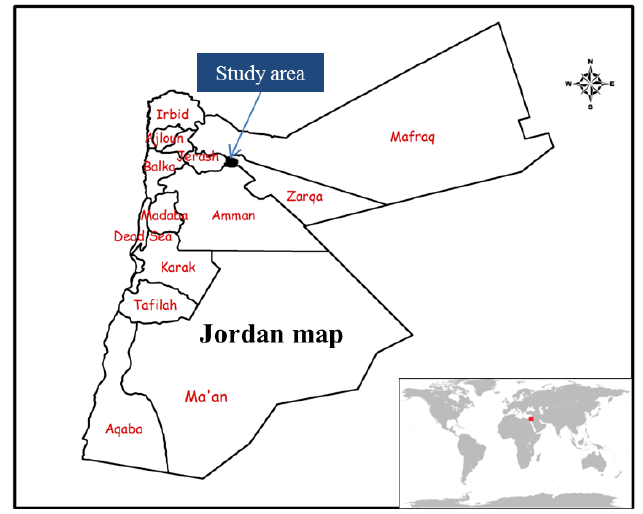
Figure 1. Location map of the study area.